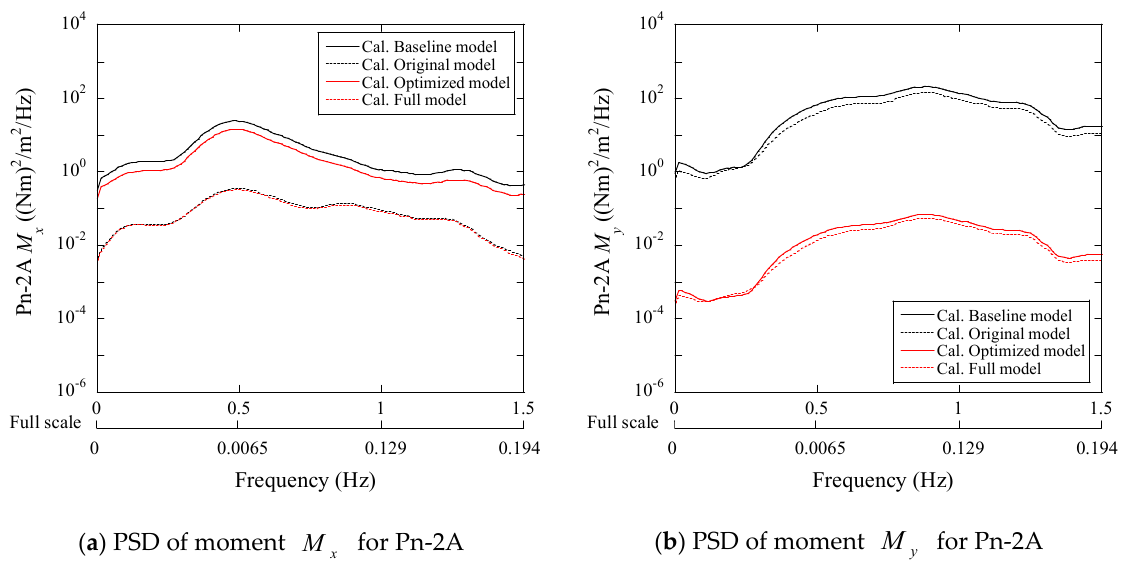
Figure 16. Comparison of normalized moments acting on three platform models in the irregular waves ( H = 0.195 m, T = 2.16 s).